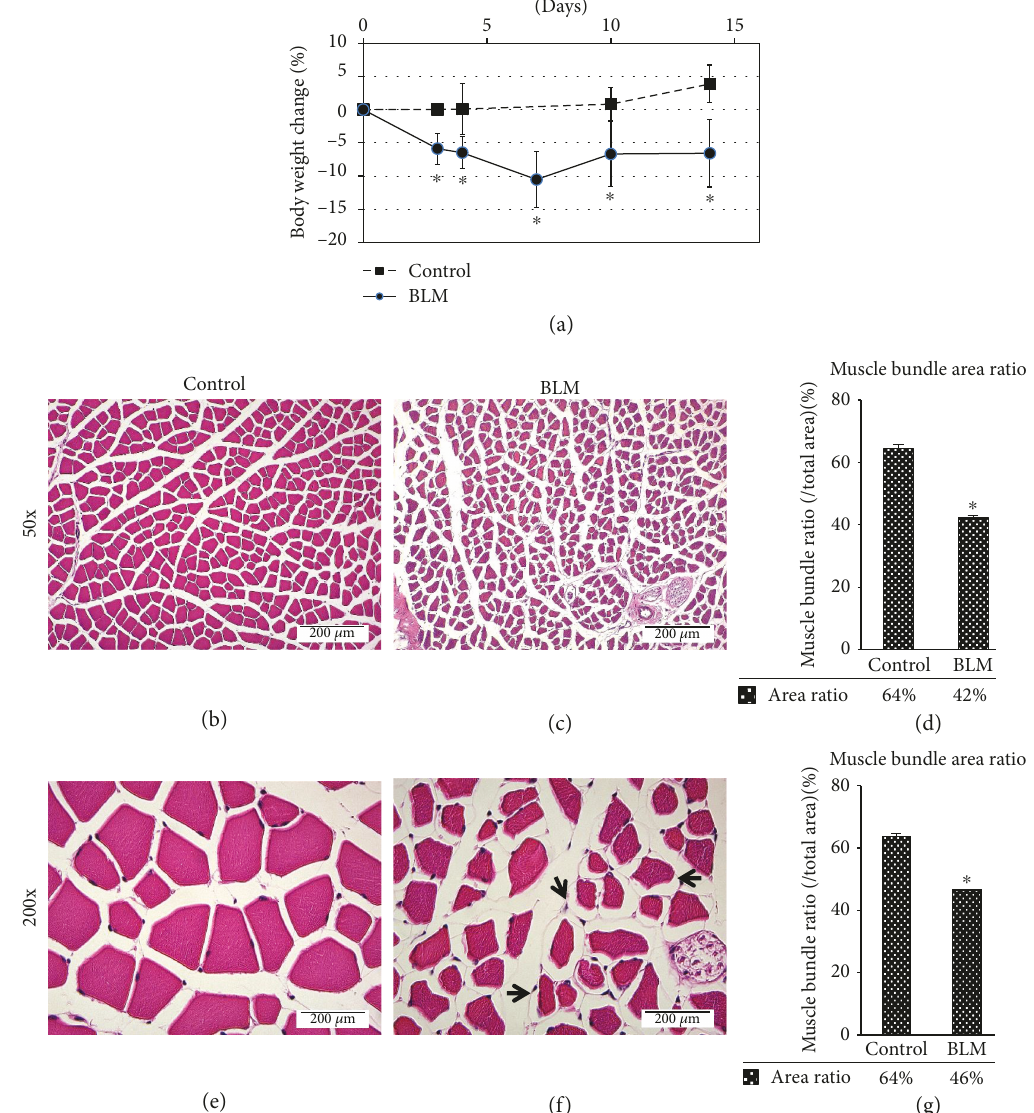
Figure 3: BLM-induced lung injury may cause body weight loss and muscle atrophy. (a) The body weights of experimental mice were measured every two to three days during the experimental periods. Square boxes represent the body weight change of control mice ( n = 6 ), and dots represent the body weight change of mice with BLM-induced lung injury ( n = 5 ). The quantitative data were expressed as the means ± SD . ∗ p < 0 05 compared with control. (b – g) Cross-sectional H&E staining of quadriceps muscle in (b, e) control mice and (c, f) mice with BLM-induced lung fi brosis. The photos represent 50x magni fi cation in (b – d) and 200x magni fi cation in (e – g). The quantitative analysis of the muscle bundle area to the total area in photos is shown in (d, g) ( n = 3 ). The values of all data are averages from at least three photos with di ff erent fi elds of view. The muscle bundle area was measured by ImageJ software. ∗ p < 0 05 compared with control mice. Bar = 200 μ m at 50x magni fi cation and 50 μ m at 200x magni fi cation as indicated. The black arrow indicates the detached basal